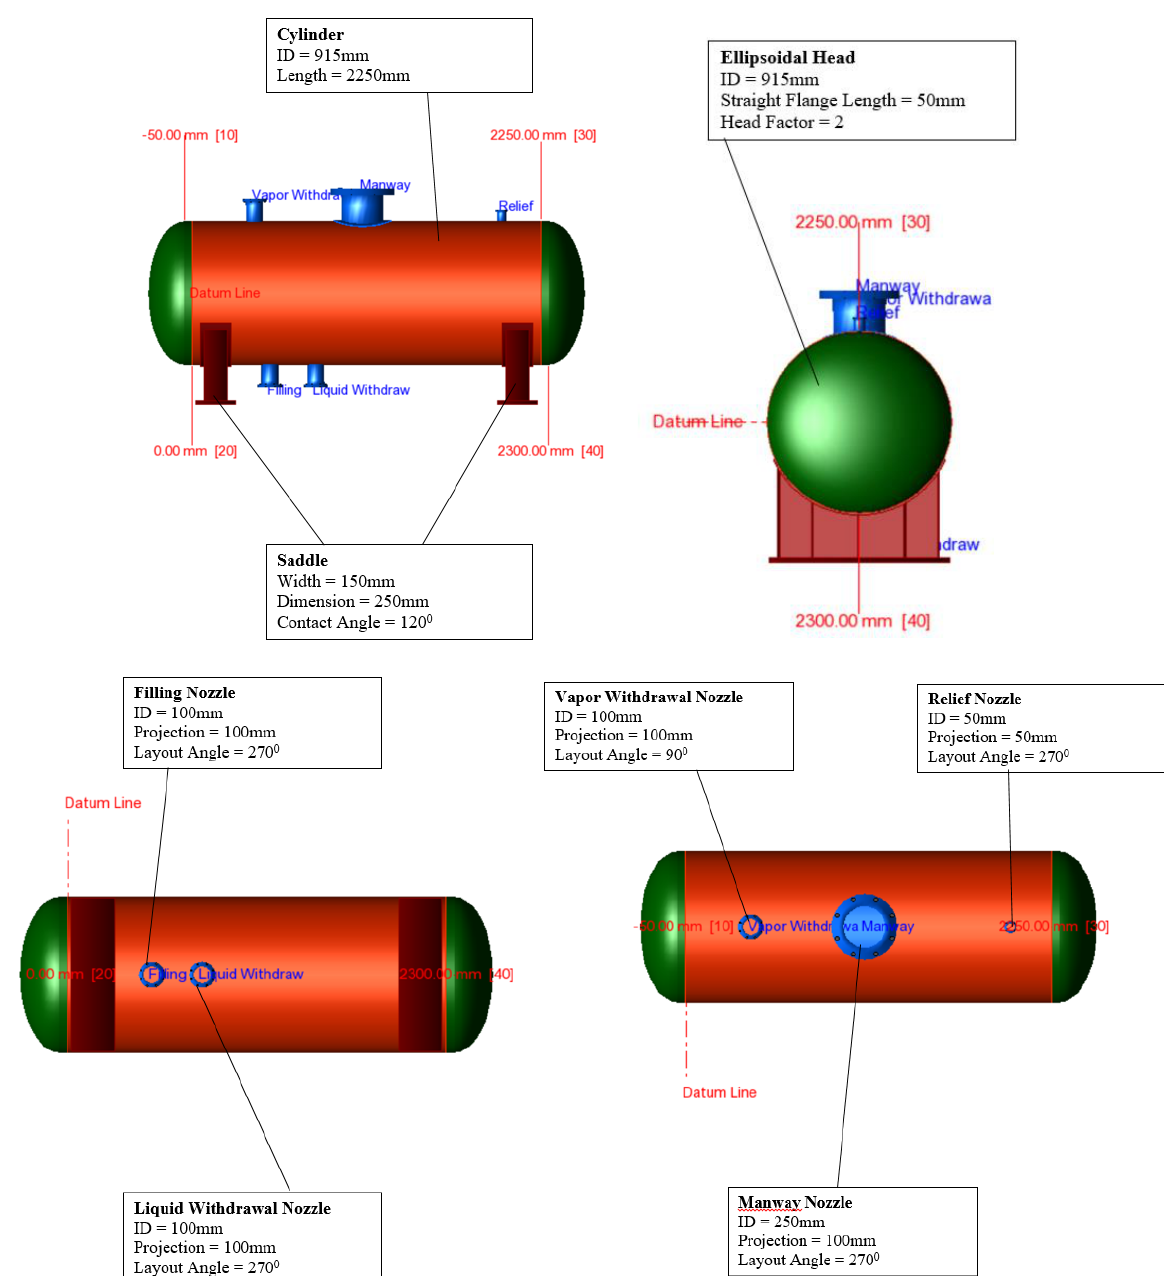
Figure 1: Design of LPG storage tank.